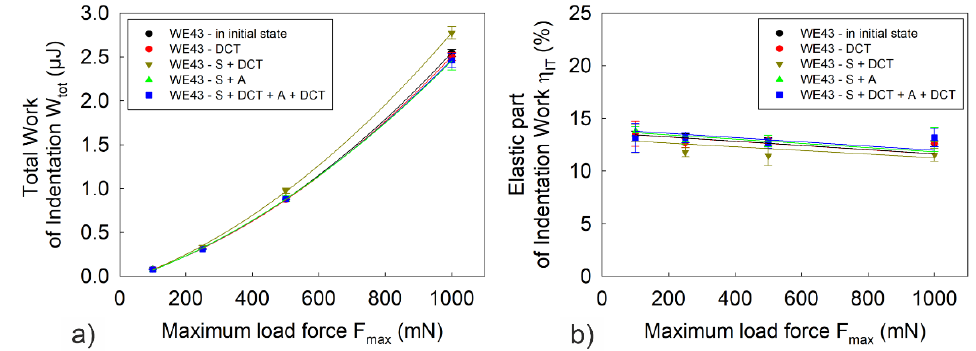
Figure 7. Total work of indentation W tot ( a ) and percentage of elastic deformation work η IT ( b ) of WE43 magnesium alloy as a function of maximum indenter load F max . The error bars in the figures represent a standard deviation ( σ Wtot = 0.002 –0.094 µJ; σ η IT = 0.08 – 1.36%).